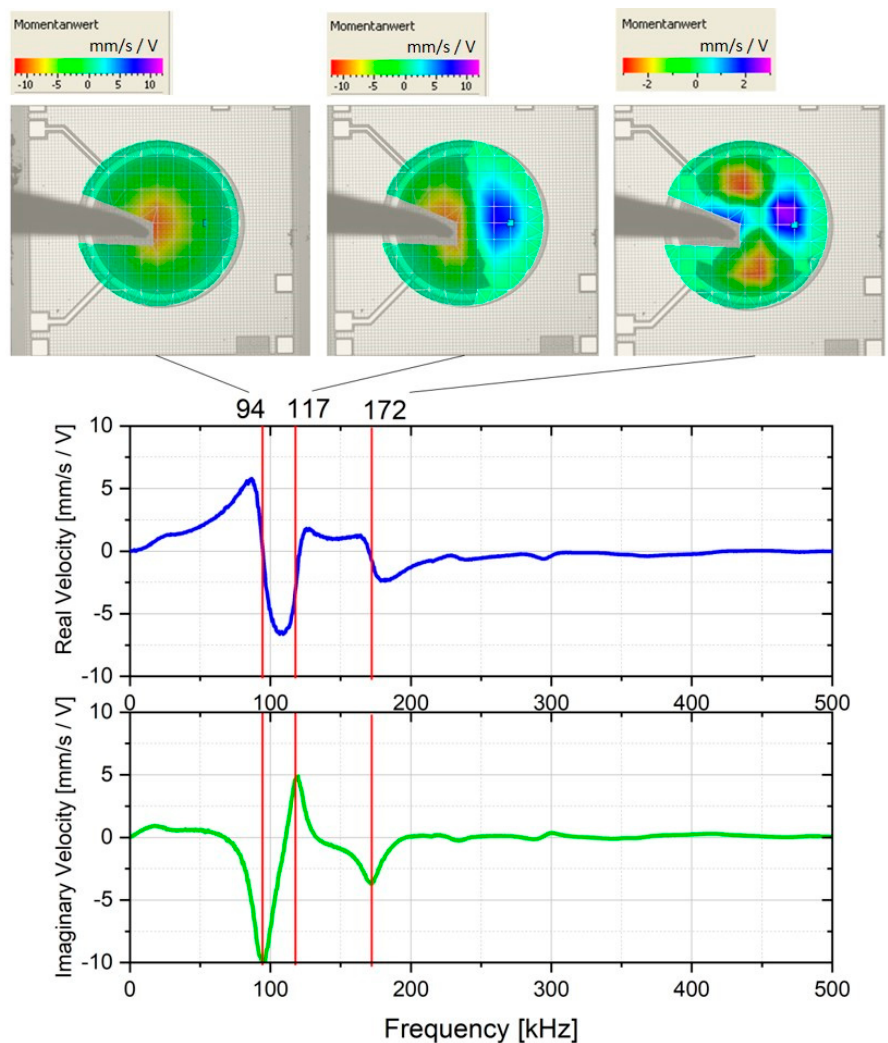
Figure 6. Averaged laser-Doppler vibrometry (LDV) measurement results of the bare CMUT dies with the images of the modes shown above at the characteristic frequency.